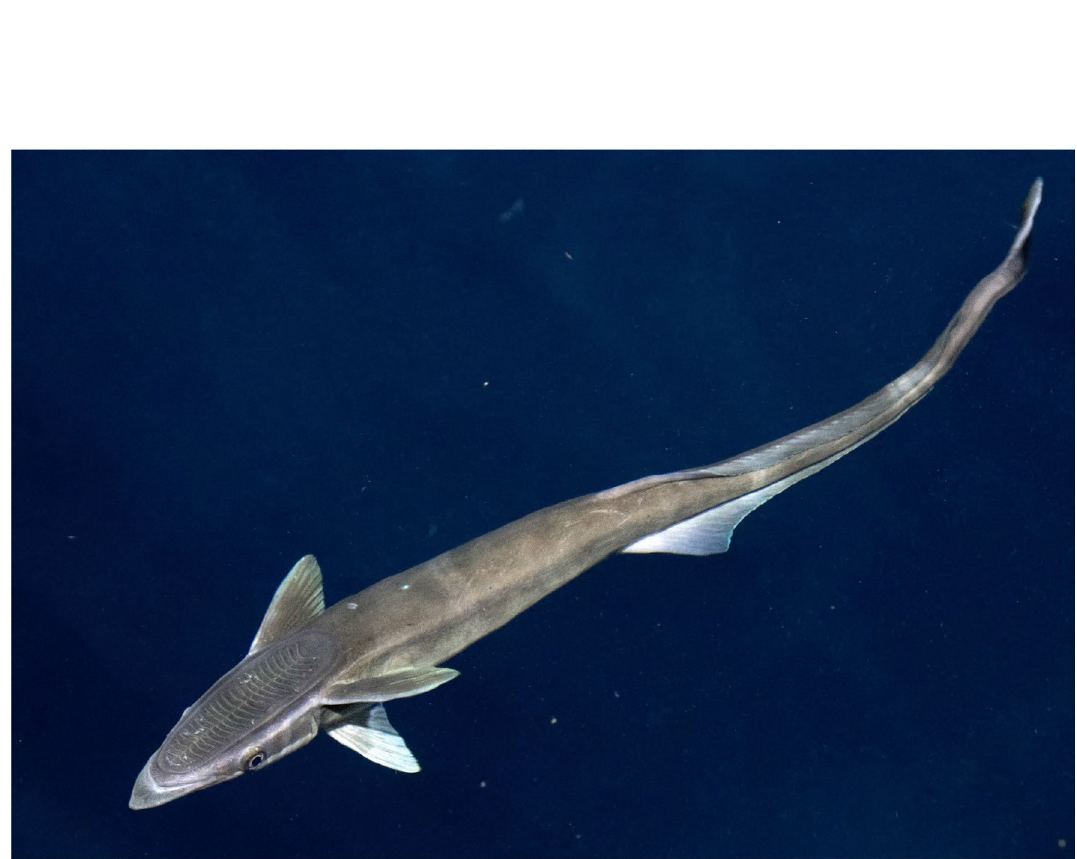
Figure 2. The suction disc of the remora (created by Andrea